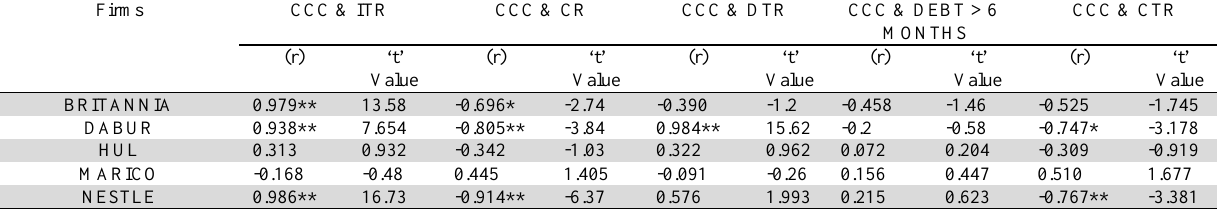
Karl Pearson’s simple correlation analysis between CCC and ITR, CR, DTR, Debt > 6 months and CTR of the selected companies from FMCG sector